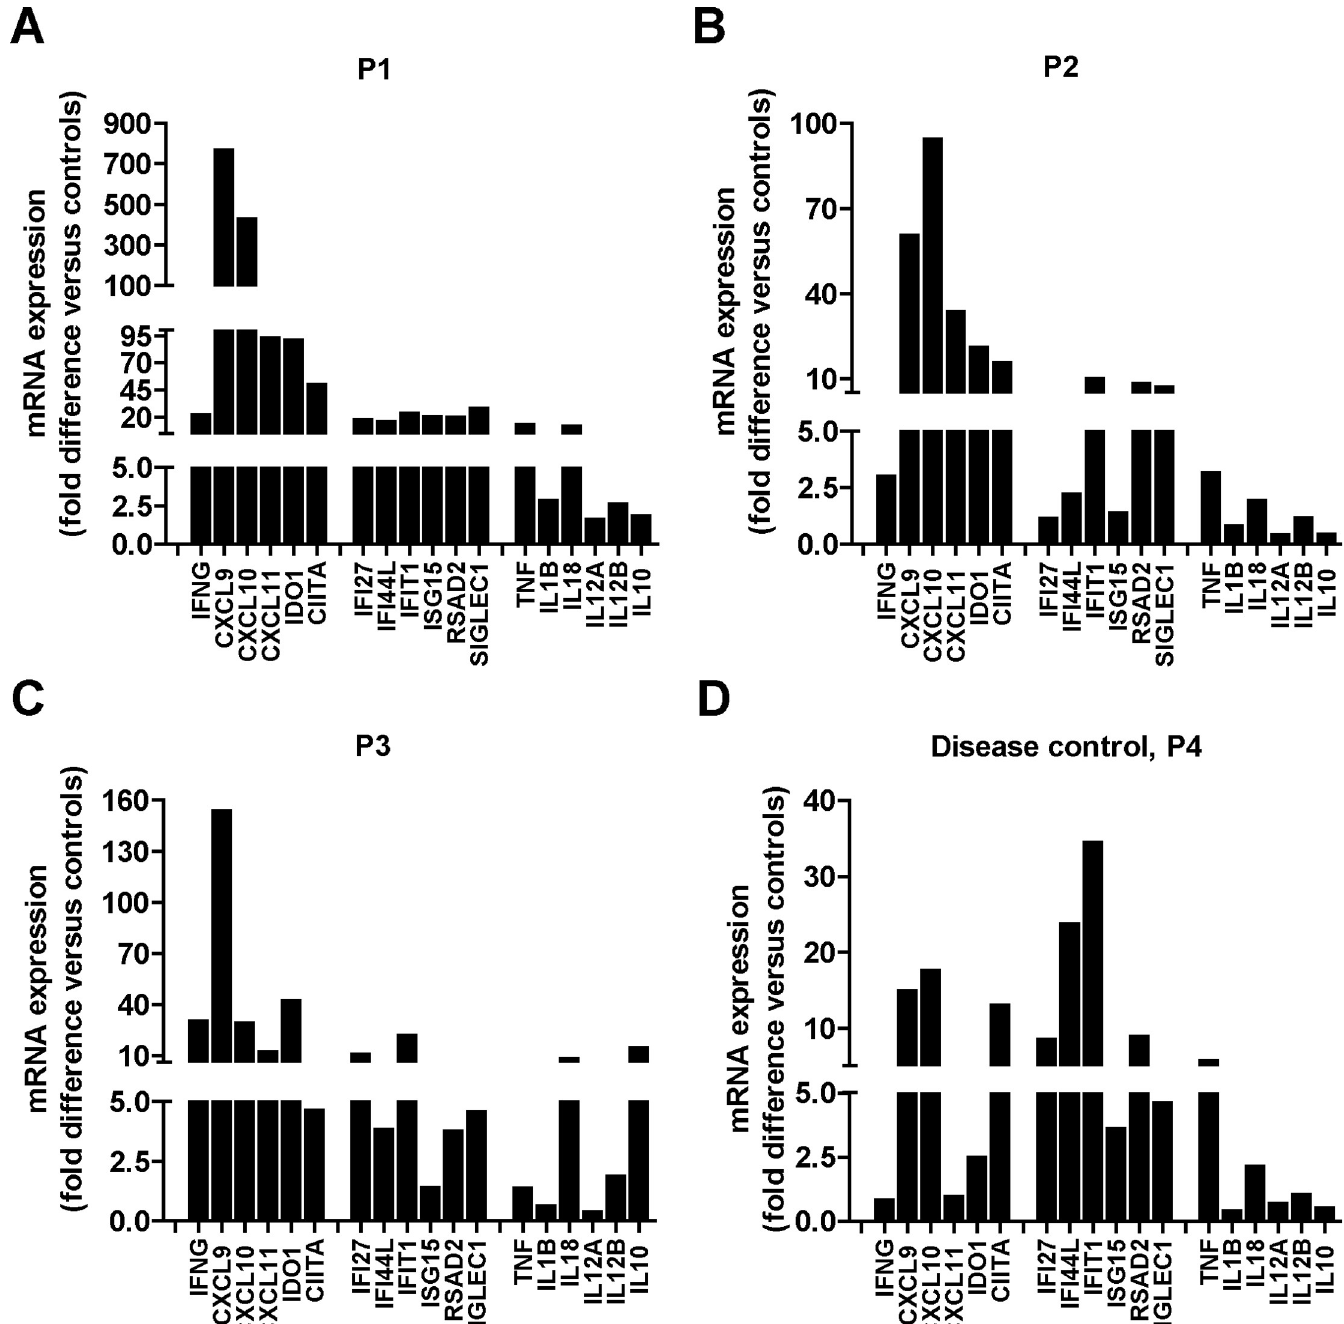
Fig 2. The IFN γ inducible genes are up-regulated in patient livers. mRNA expression levels of IFNG , IFN γ -inducible genes ( CXCL9 , CXCL10 , CXCL11 , IDO1 , CIITA ), Type I IFN-inducible genes ( IFI27L , IFI44L , IFIT1 , ISG15 , RSAD2 , SIGLEC1 ) and inflammatory cytokine genes ( TNF , IL1B , IL18 , IL12A , IL12B , IL10 ) were assayed in the liver from P1 (A) , P2 (B) , P3 (C) with sHLH and from P4 (D) with autoimmune hepatitis (disease control). Results are expressed as fold difference as compared with mean values obtained from control livers (n = 3), after normalization with the housekeeping gene HPRT1 .